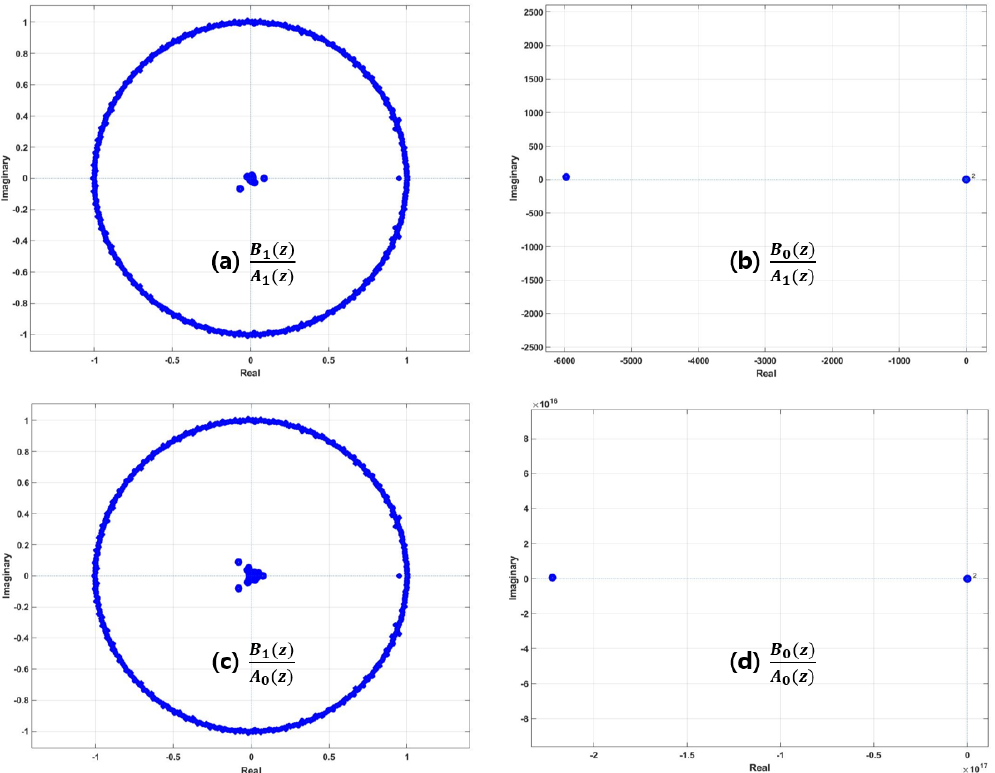
Figure 9. Examples of classification of respiratory status of A j ( t ) given B i ( t ) using Z-transform. ( a , c ) Respiratory status of A j ( z ) given abnormal respiration B 1 ( z ) . ( b , d ) Respiratory status of A j ( z ) given normal respiration B 0 ( z )